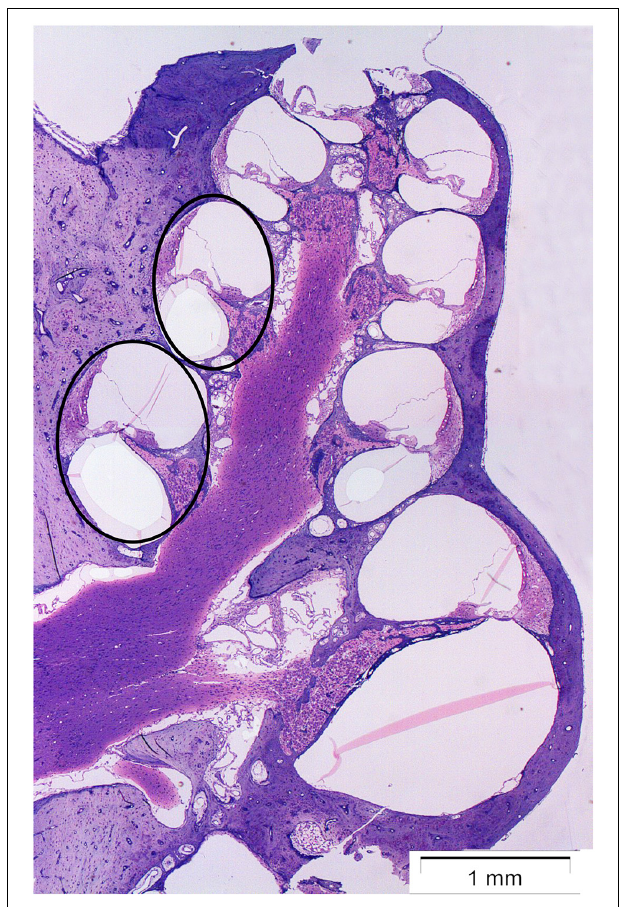
FIGURE 1 | Micrograph showing a midmodiolar cross-section of the normal guinea pig cochlea. The black circles indicate the two points on the basilar membrane 12 mm (middle turn) and 7 mm (basal turn) from the round window, where the immunoreactivity of synaptophysin, and Iba1 was